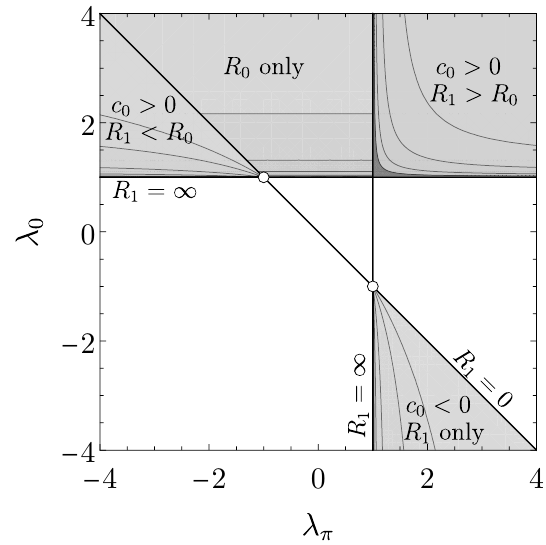
Figure 3. Allowed regions ((cid:12)lled) for the normalized brane tensions (cid:21) 0 ; (cid:21) (cid:25) for the Nihei-Kaloper- Kim-Kim special case. The contours illustrate the value of R 1 where it is allowed and otherwise the value of R 0 (darker means bigger) such that a consistent solution is achieved. The Hubble rate of the visible brane is everywhere given by (3.39). Contour lines with constant R can also be viewed as parametric curves on which the general expression for H 2 , Equation (3.19), is reconciled with